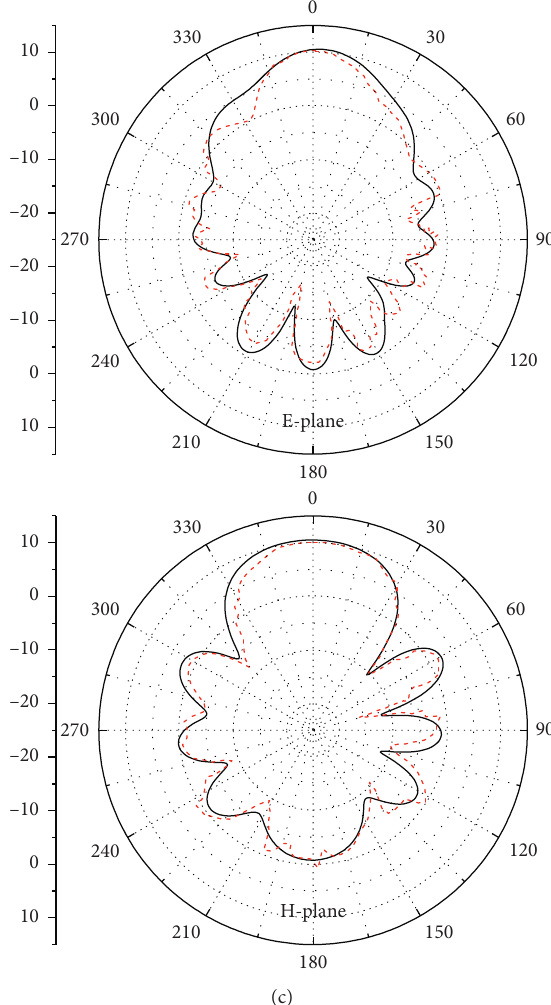
Figure 10: Simulated and measured radiation patterns for E-plane ( yz -plane) and H-plane ( xz -plane) of the fabricated antenna. (a) 3 GHz. (b) 7 GHz. (c) 10GHz. (Sim. , Mea.